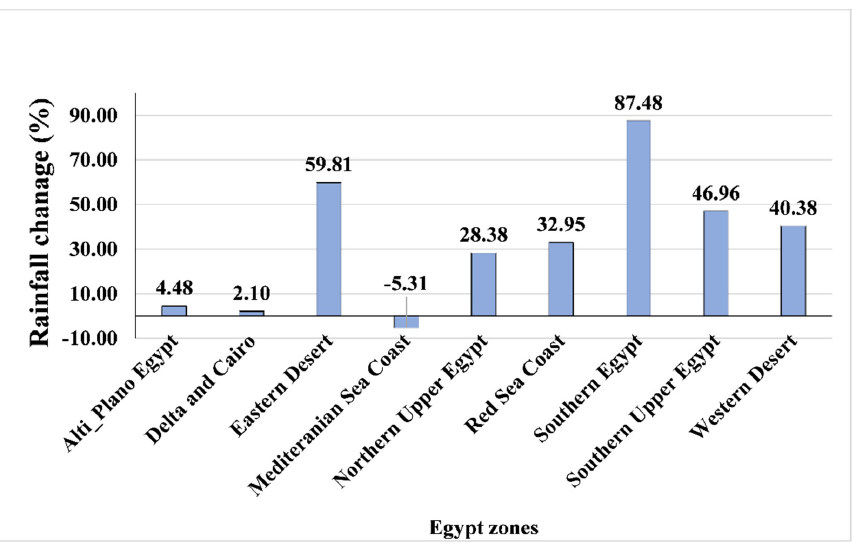
Figure 3. The zonal rainfall changes in Egypt between the past period (1950–2014) and the future period (2015–2099).